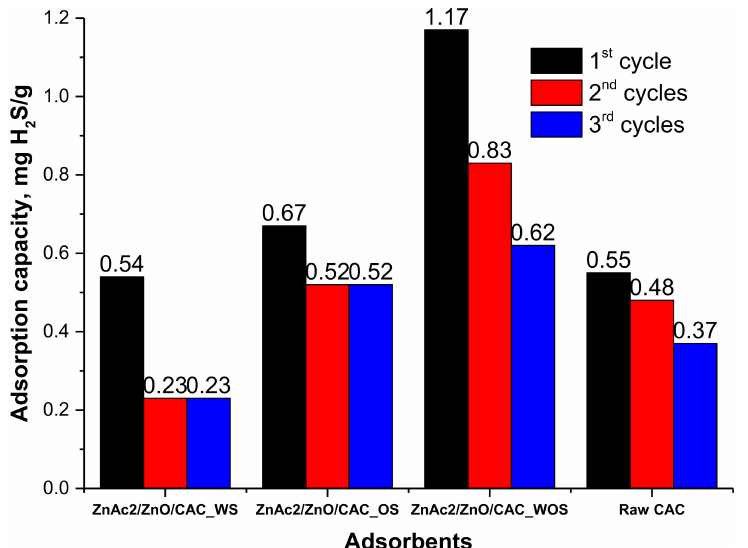
Figure 9. Regeneration performance of adsorbents throughout three adsorption-desorption cycles. Each cycle of adsorption-desorption has shown a degradation in the efficiency of the adsorbent. For ZnAc 2 /ZnO/CAC_WS adsorbents at 150 ◦ C, the decrease in the efficiency of the second cycle was 57.4% compared to the first cycle. Then, in the third cycle, the efficiency of the adsorption-desorption remained as in the second cycle. Besides, the degradation in ZnAc 2 /ZnO/CAC_OS showed a 22.4% decrease in the efficiency of the second cycle and it remained present in the third cycle. The ZnAc 2 /ZnO/CAC_WOS had a higher capabil- ity in capturing H 2 S compared to ZnAc 2 /ZnO/CAC_WS and to ZnAc 2